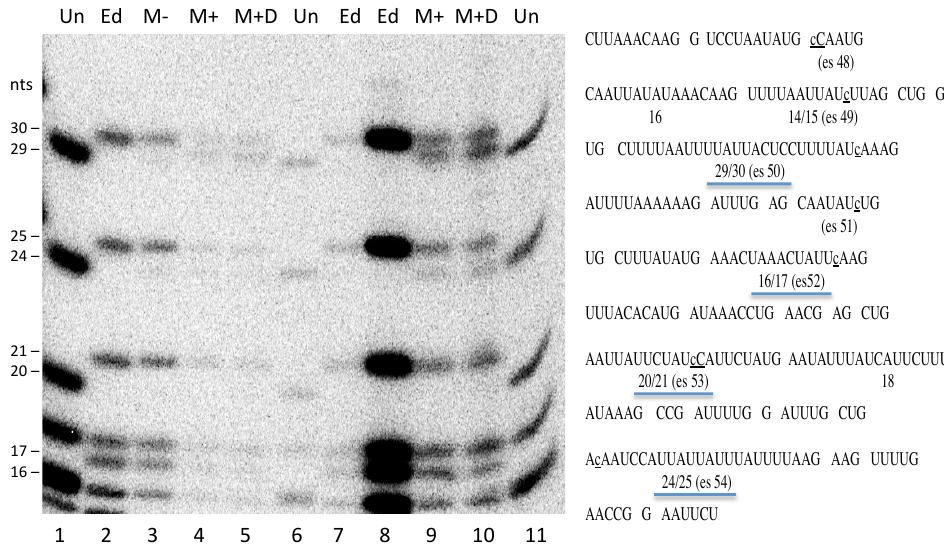
Figure 4. The editing machinery is still functional after electroporation. Gel electrophoresis of RNase T1 products generated from S1 nuclease-protected RNA fragments that encompass the last seven editing sites of the atpA mRNA. Internally labeled RNAs were synthesized by mitochondria before electroporation (M − , lane 3), mitochondria after electroporation in the absence of exogenous DNA (M+, lanes 4 and 9), and mitochondria after electroporation in the presence of exogenous DNA (M +D, lanes 5 and 10). Different amounts of the same RNase T1 digests were loaded in lanes 4 and 9 and lanes 5 and 10. Multiple dilutions of RNase T1 digests of S1 nuclease-protected unedited (Un, lanes 1, 6, and 11) and edited (Ed, lanes 2, 7, and 8) control transcripts were run alongside for comparison. The sequence of the RNase T1 fragments from the protected region of the atpA mRNA is shown at the right, with the C residue added at editing sites 48 through 54 (es48–es54) indicated by a lower case c. Easily resolvable RNase T1 fragments diagnostic of editing are underlined and the size in nucleotides (nts) of the edited and unedited fragments are indicated on the sequence and to the left of the